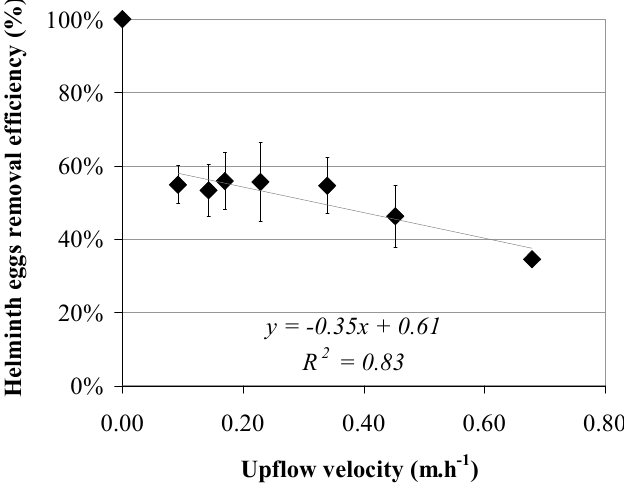
Figure 6. Helminth egg removal efficiencies ( ♦ ) versus upflow velocity using a sludge bed height between 0.60 and 0.70 m.